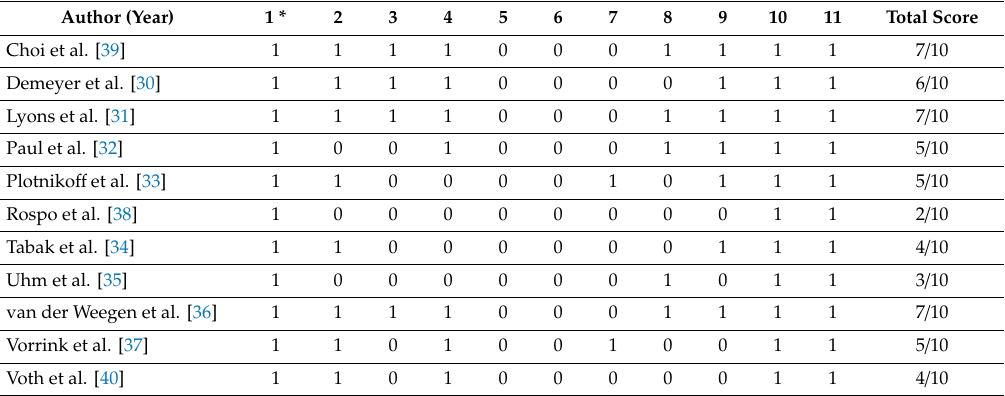
Table 1. Quality assessment (PEDro scale) of the included studies (n =